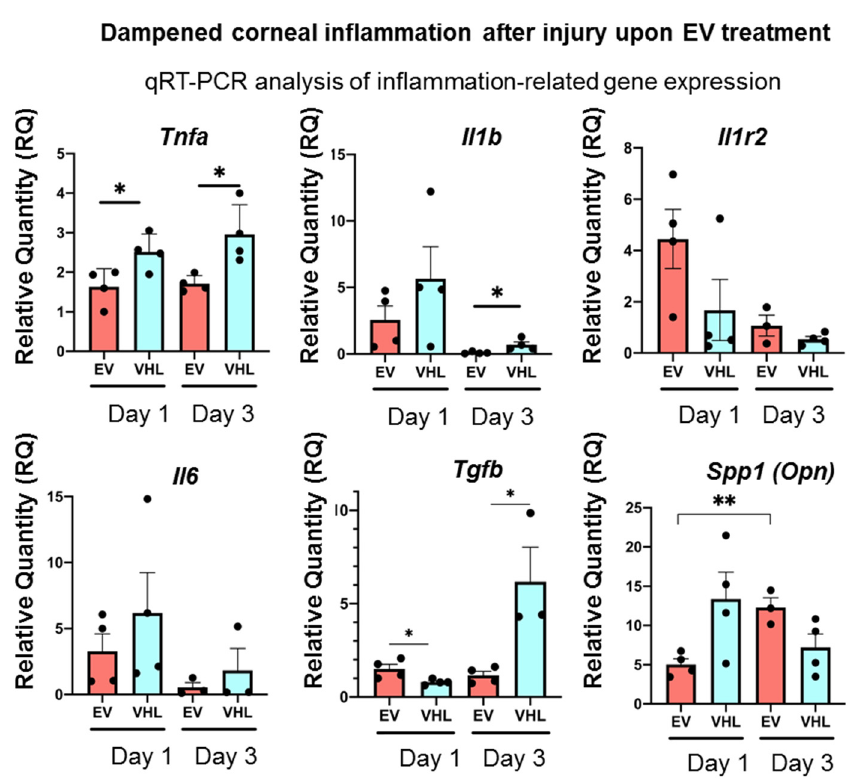
Figure 6. Dampened corneal inflammation after injury upon BMSC-EV treatment. Inflammation- related gene expression assessed by qRT-PCR at different timepoints post-alkali burn injury and upon BMSC-EV- and VHL-treatment. Mean ± SD is shown and is representative of 2 independent experiments (n = 4, * p < 0.05, ** p < 0.01) . ● represents biological replicates